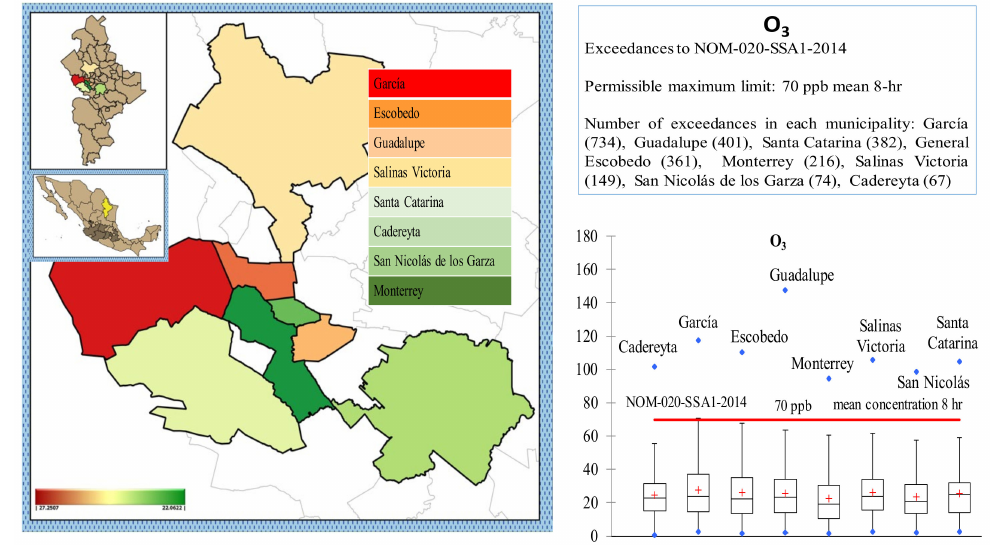
Figure 4. Mean concentrations of O 3 in MAM during